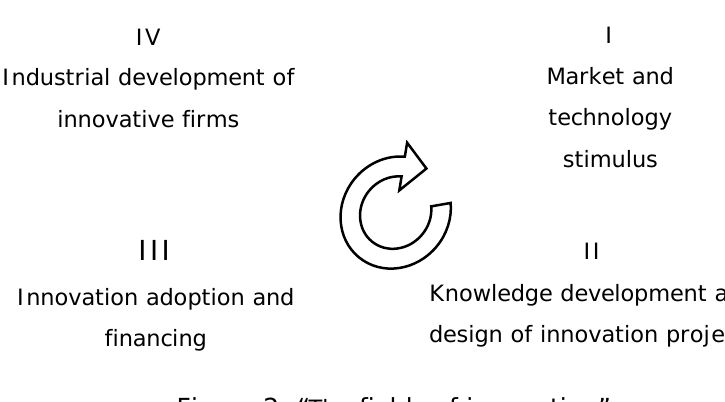
Figure 2. “ The fields of